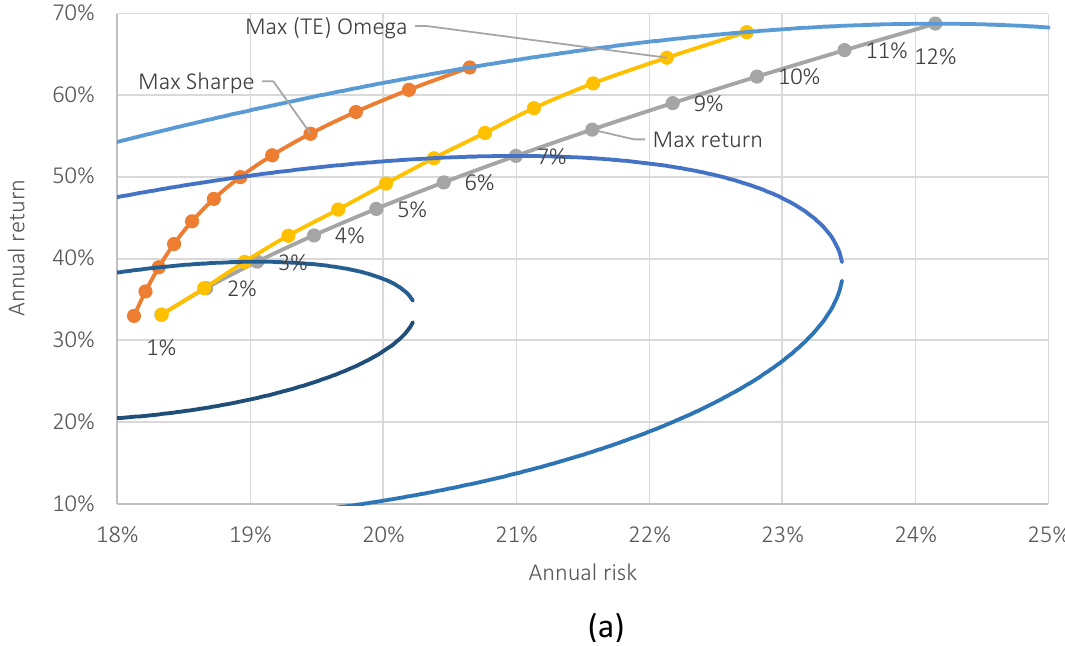
Figure 6(a). Return/risk profiles for relevant portfolios as a function of TE (percentages indicate TE Figure 8 compares weight deviations from the three portfolios’ benchmark over (a) the Oct-00 – Oct-05 period and (b) the Oct-09 – Oct-14 period.